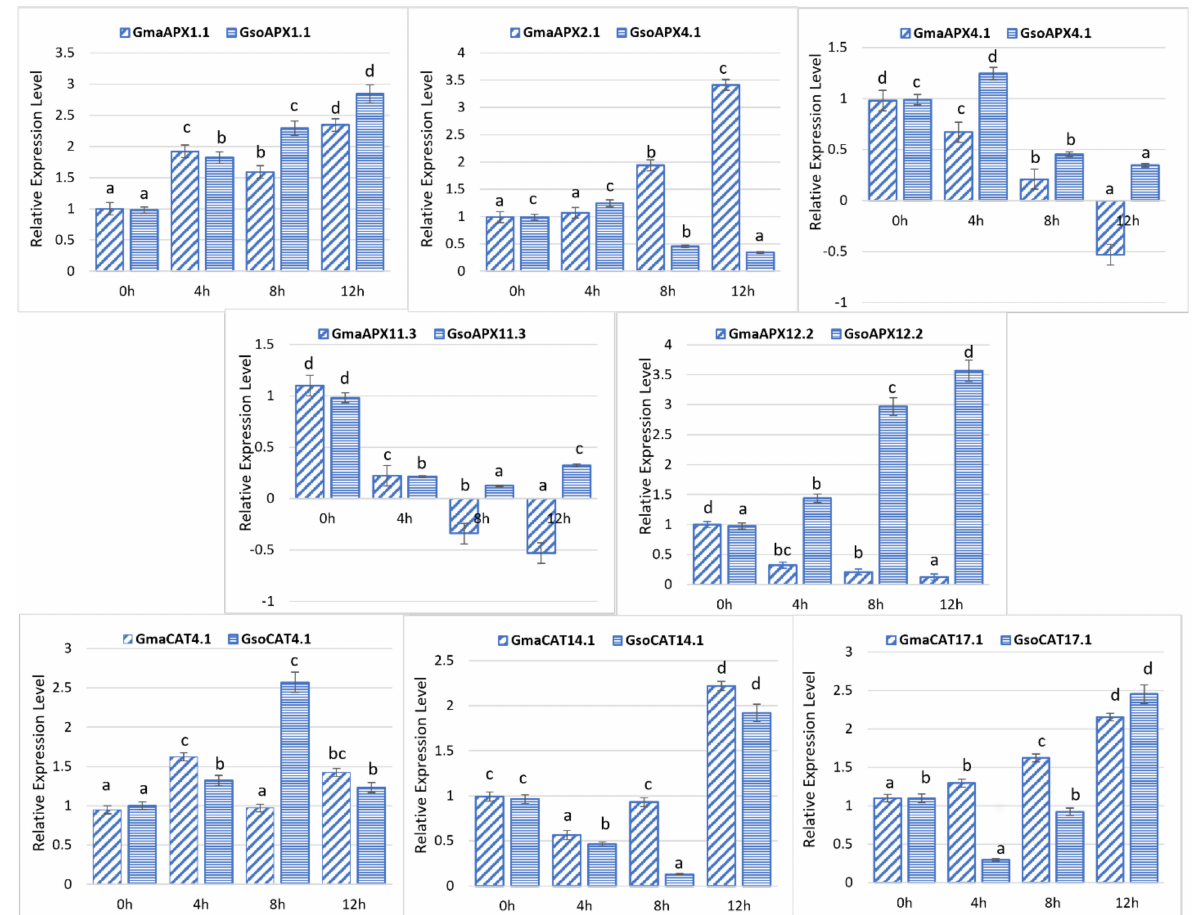
Figure 9. Expression pattern of selected APX and CAT genes of G. soja and G.max under drought stress. Data depict mean and standard deviation of three replicates (n = 3). Data with the same letters in lowercase (a, b, c and d) above bars indicate no significant differences at the 0.05 level at different time intervals in the soybean genotype according to Duncan’s multiple range